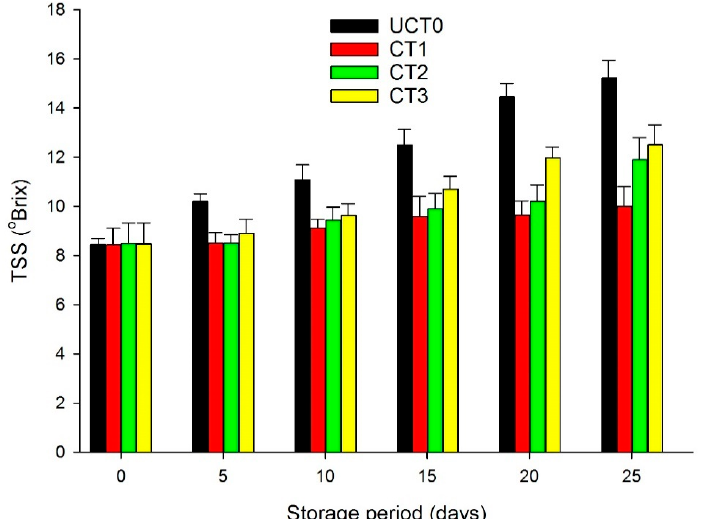
Figure 5. Presence of total soluble solids (°Brix) of Golden Delicious apple slices coated (with CT1, CT2, and CT3), and not treated (UCT0) at day 0, and after 5, 10, 15, 20, and 25-days of storage at 4 °C in dark conditions and 85% relative humidity (RH). Values indicate the means ± standard deviations ( n = 3). Abbreviations: UCT0, uncoated apple slices used as control; CT1, apple slices coated with chitosan-glycerol-cinnamon oil; CT2, apple slices coated with guar gum-glycerol-cinnamon oil; CT3, apple slices coated with composite guar gum-starch-glycerol-cinnamon oil.